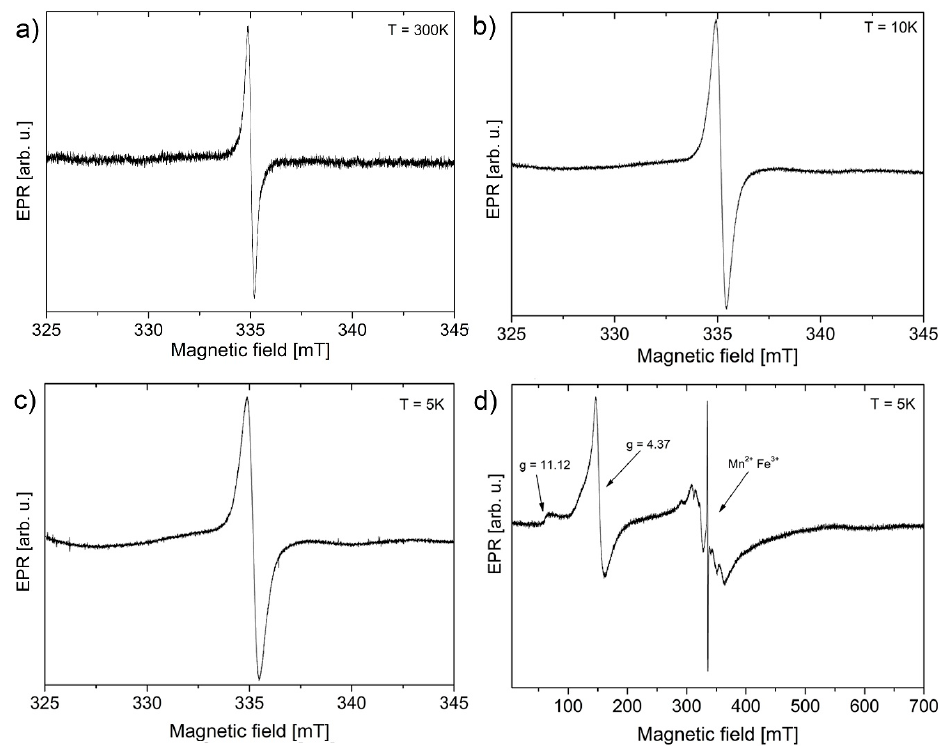
Figure 5. Electron paramagnetic resonance (EPR) lines recorded at ( a ) 300, ( b ) 10, ( c ) 5, and ( d ) 5 K over the full range with maximal gain. All measurements were performed on obtained dried GOQDs.